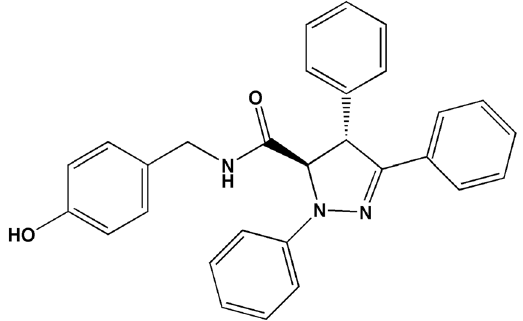
Figure 1. Chemical structure of